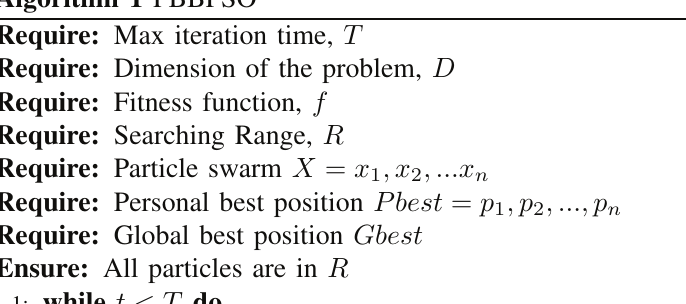
Algorithm 1 PBBPSO